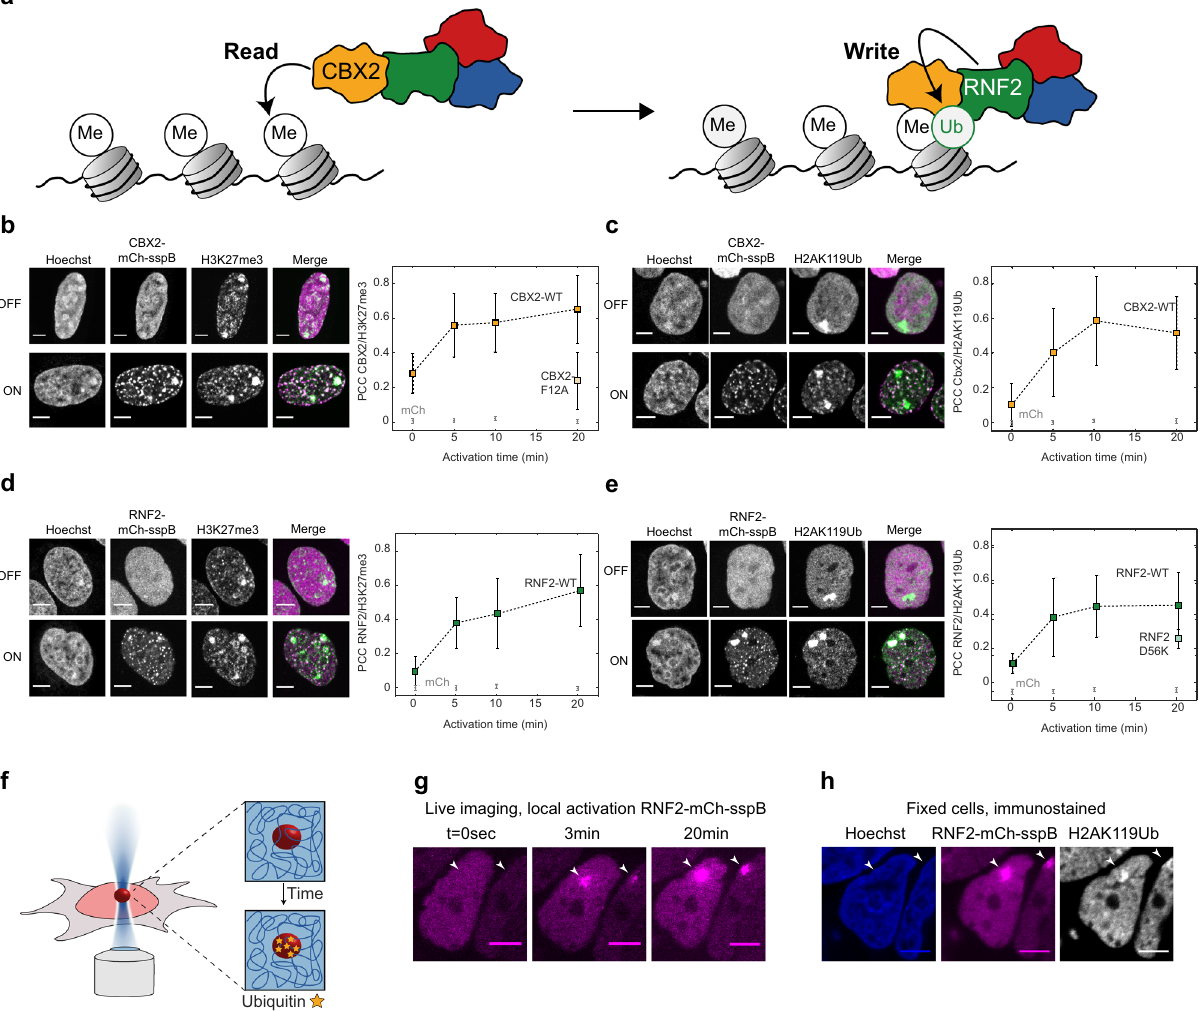
Fig. 4 PRC1 condensates recognize and write repressive histone marks. a The Cbx subunit of PRC1 recognizes the H3K27me3 mark, and the RING subunit writes the H2AK119Ub mark. b Immuno fl uorescence on the H3K27me3 mark in fi xed CBX2-mCh-sspB Corelet cells, before (OFF) and after (ON) activation. CBX2-mCh-sspB colocalizes with H3K27me3 marks upon light activation ( n = 38/38/36/36 cells for 0/5/10/20min for Cbx2, n = 18/9/7/5 cells for 0/5/10/20 min for mCh). The CBX2_F12A-mCh-sspB mutant is unable to recognize the H3K27me3 mark ( n = 18 cells at 20 min). Scale bar is 5 µ m. Data are presented as mean values + / − SD. c Immuno fl uorescence staining of the H2AK119Ub mark in fi xed CBX2-mCh-sspB Corelet cells, before (OFF) and after (ON) activation. CBX2-mCh-sspB colocalizes with H2AK119Ub marks upon light activation ( n = 40/41/31/37 cells for 0/5/10/20 min for Cbx2, n = 14/8/4/14 cells for 0/5/10/20 min for mCh). Data are presented as mean values + / − SD. d Immuno fl uorescence staining of the H3K27me3 mark in fi xed RNF2-mCh-sspB Corelet cells, before (OFF) and after (ON) activation. RNF2-mCh-sspB colocalizes with H3K27me3 marks upon light activation ( n = 28/29/30/25 cells for 0/5/10/20 min for Cbx2, n = 18/9/7/5 cells for 0/5/10/20 min for mCh). Data are presented as mean values + / − SD. e Immuno fl uorescence staining of the H2AK119Ub mark in fi xed RNF2-mCh-sspB Corelet cells, before (OFF) and after (ON) activation. RNF2-mCh-sspB colocalizes with H2AK119Ub marks upon light activation ( n = 42/29/29/36 cells for 0/5/10/20 min for Cbx2, n = 14/8/4/14 cells for 0/5/10/20 min for mCh). The RNF2_D56K-mCh-sspB mutant shows less colocalization with the H2AK119Ub mark ( n = 32 cells at 20 min). Data are presented as mean values + / − SD. f Schematic of local activation experiment. Each cell is locally activated in a 1 micron 2 area for 20 min, after which the cells are rapidly fi xed. Fixed cells are immunostained with anti-H2AK119ub antibody and stained with Hoechst. g Local activation of RNF2-mCh-sspB. Arrows indicate region of interest. Scale bar is 5 µ m. h Fixed cells after local activation of RNF2-mCh-sspB, stained with Hoechst and anti- H2AK119Ub immuno fl uorescence. Scale bar is 5 µ